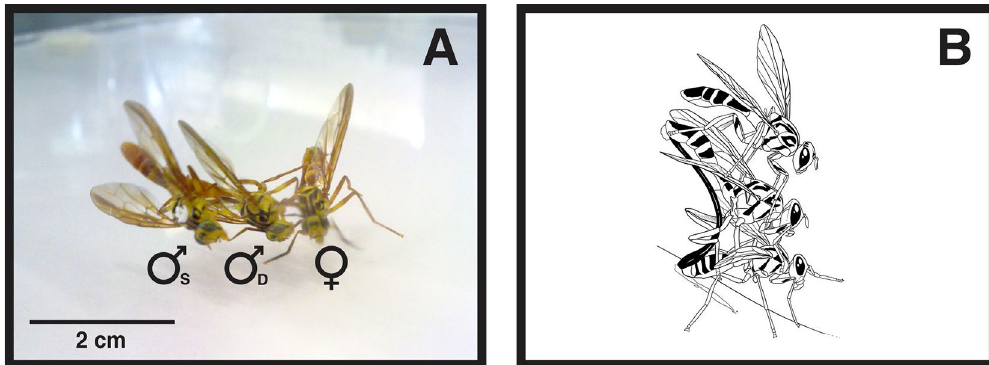
Figure 1. Tandem behavior of Anastrepha curvicauda ( A ) a female ( ♀ ) is mounted by a dominant male ( ♂ D ) and this male is mounted by a subordinated male ( ♂ S ) and ( B ) graphic representation of the tandem behavior.